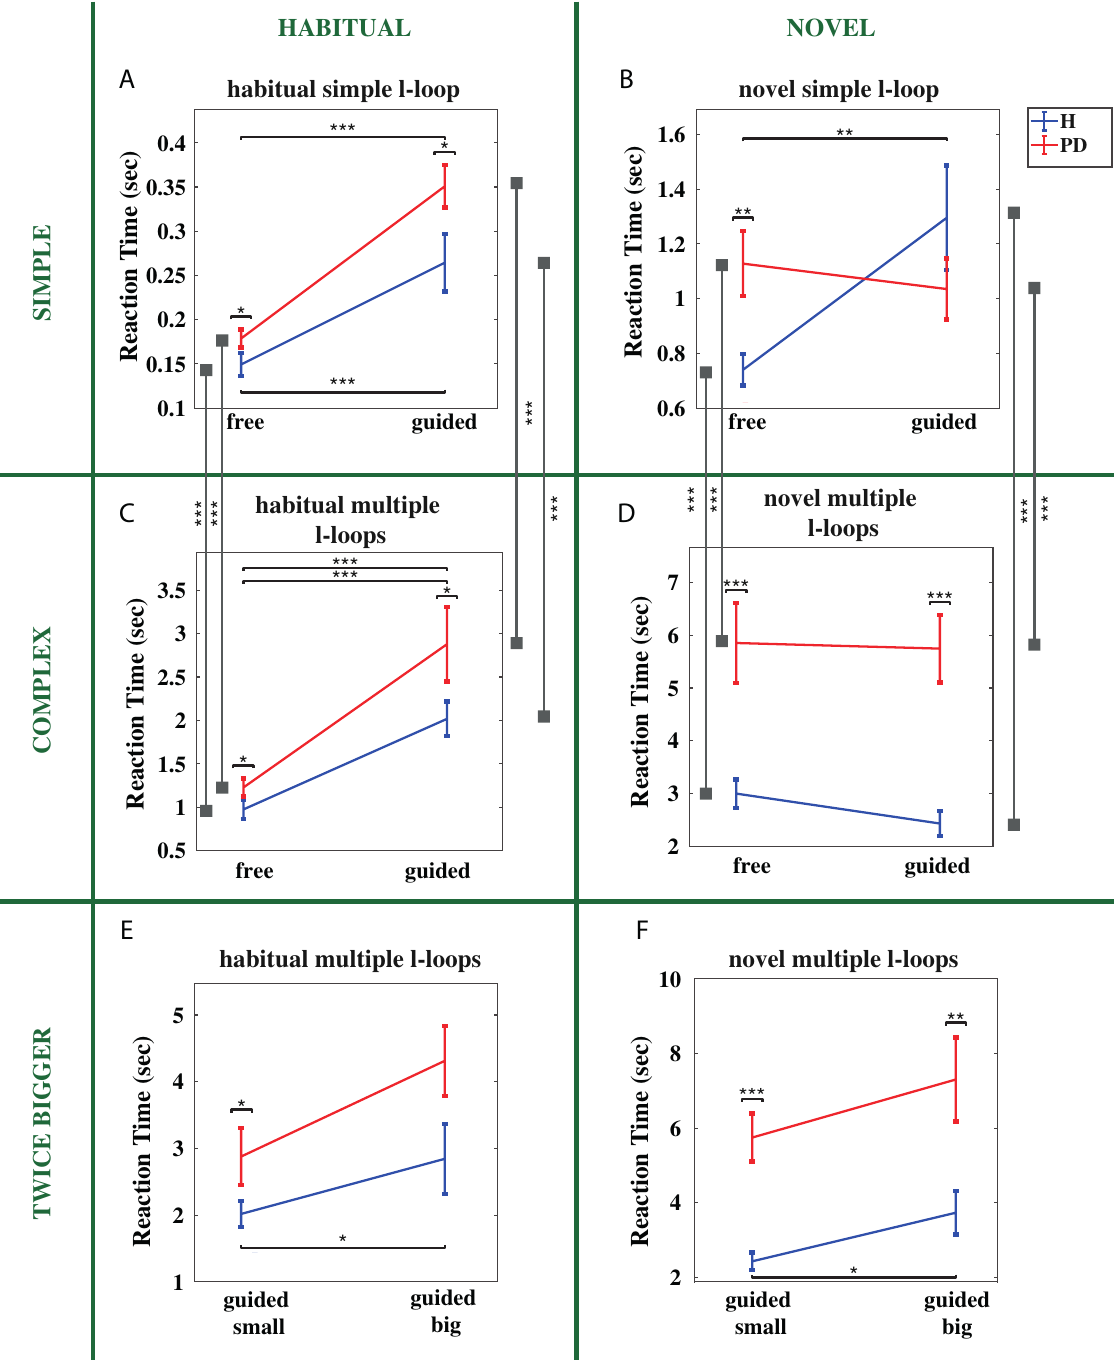
Figure 8. Reaction Time (mean ± SEM) across PD patients (red lines) and H subjects (blue lines) for all conditions: ( A ) Habitual simple l-loop, ( B ) Novel simple l-loop, ( C ) Habitual multiple l-loops, ( D ) Novel multiple l-loops, ( E ) Habitual multiple l-loops, ( F ) Novel multiple l-loops. Grey and black lines indicate the results of t -tests that gave significant differences. Stars indicate the results of one-tailed t -tests corrected with the FDR procedure (* p < 0.05; ** p < 0.01; *** p <